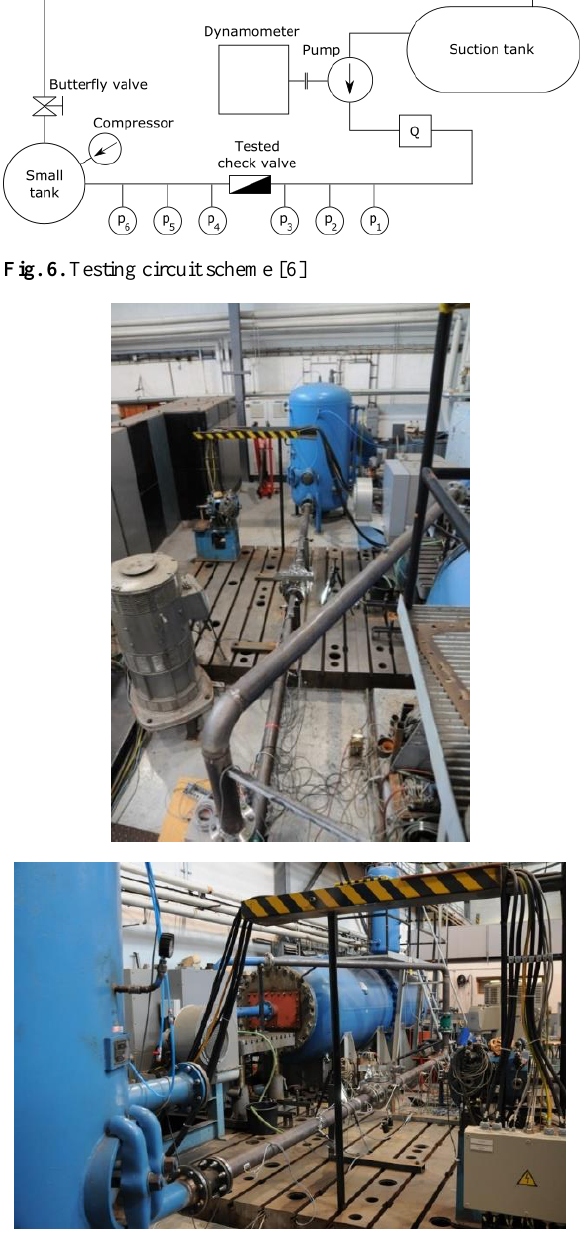
Fig. 7. Picture of the Testing